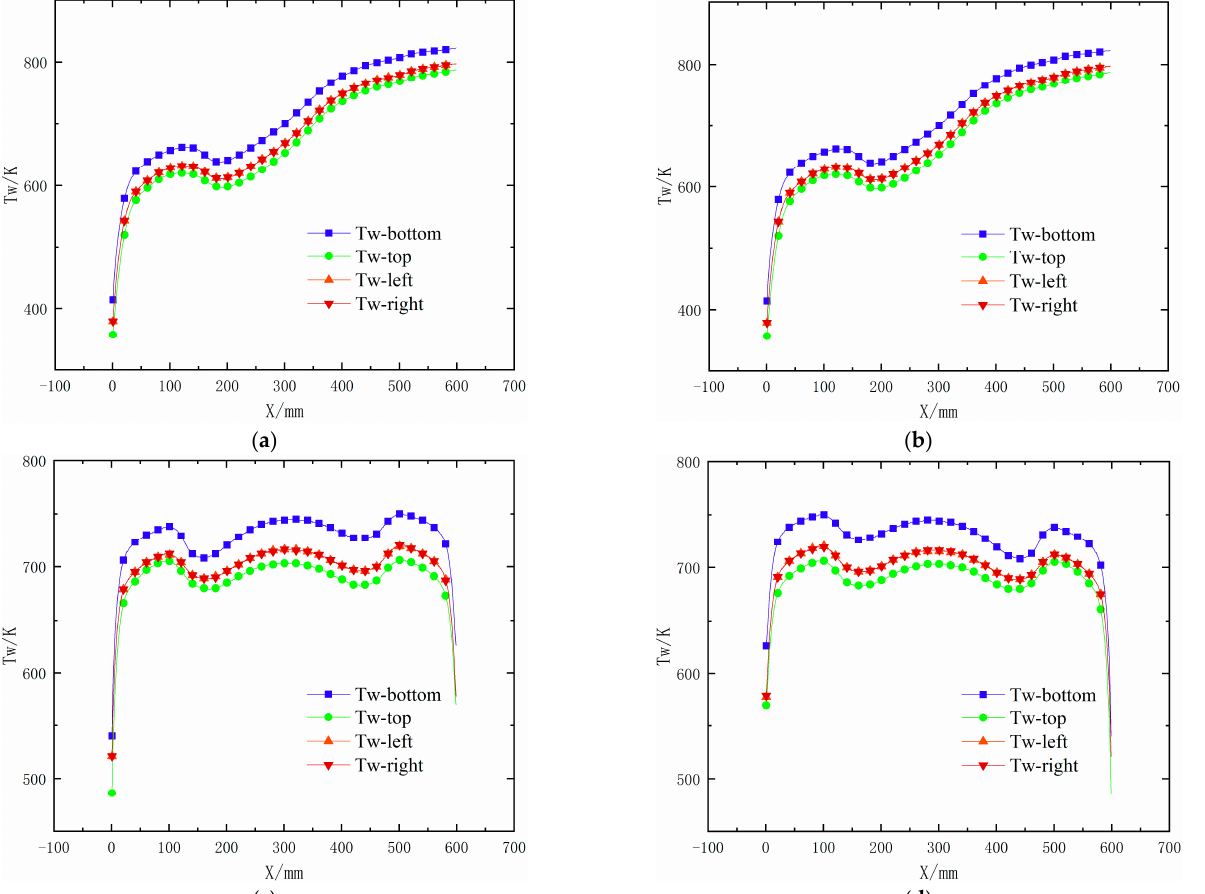
Figure 7. Temperature distributions of four side walls along the X-axis: ( a ) Case A, CH1; ( b ) Case A, CH2; ( c ) Case B, CH1; ( d ) Case B, CH2.